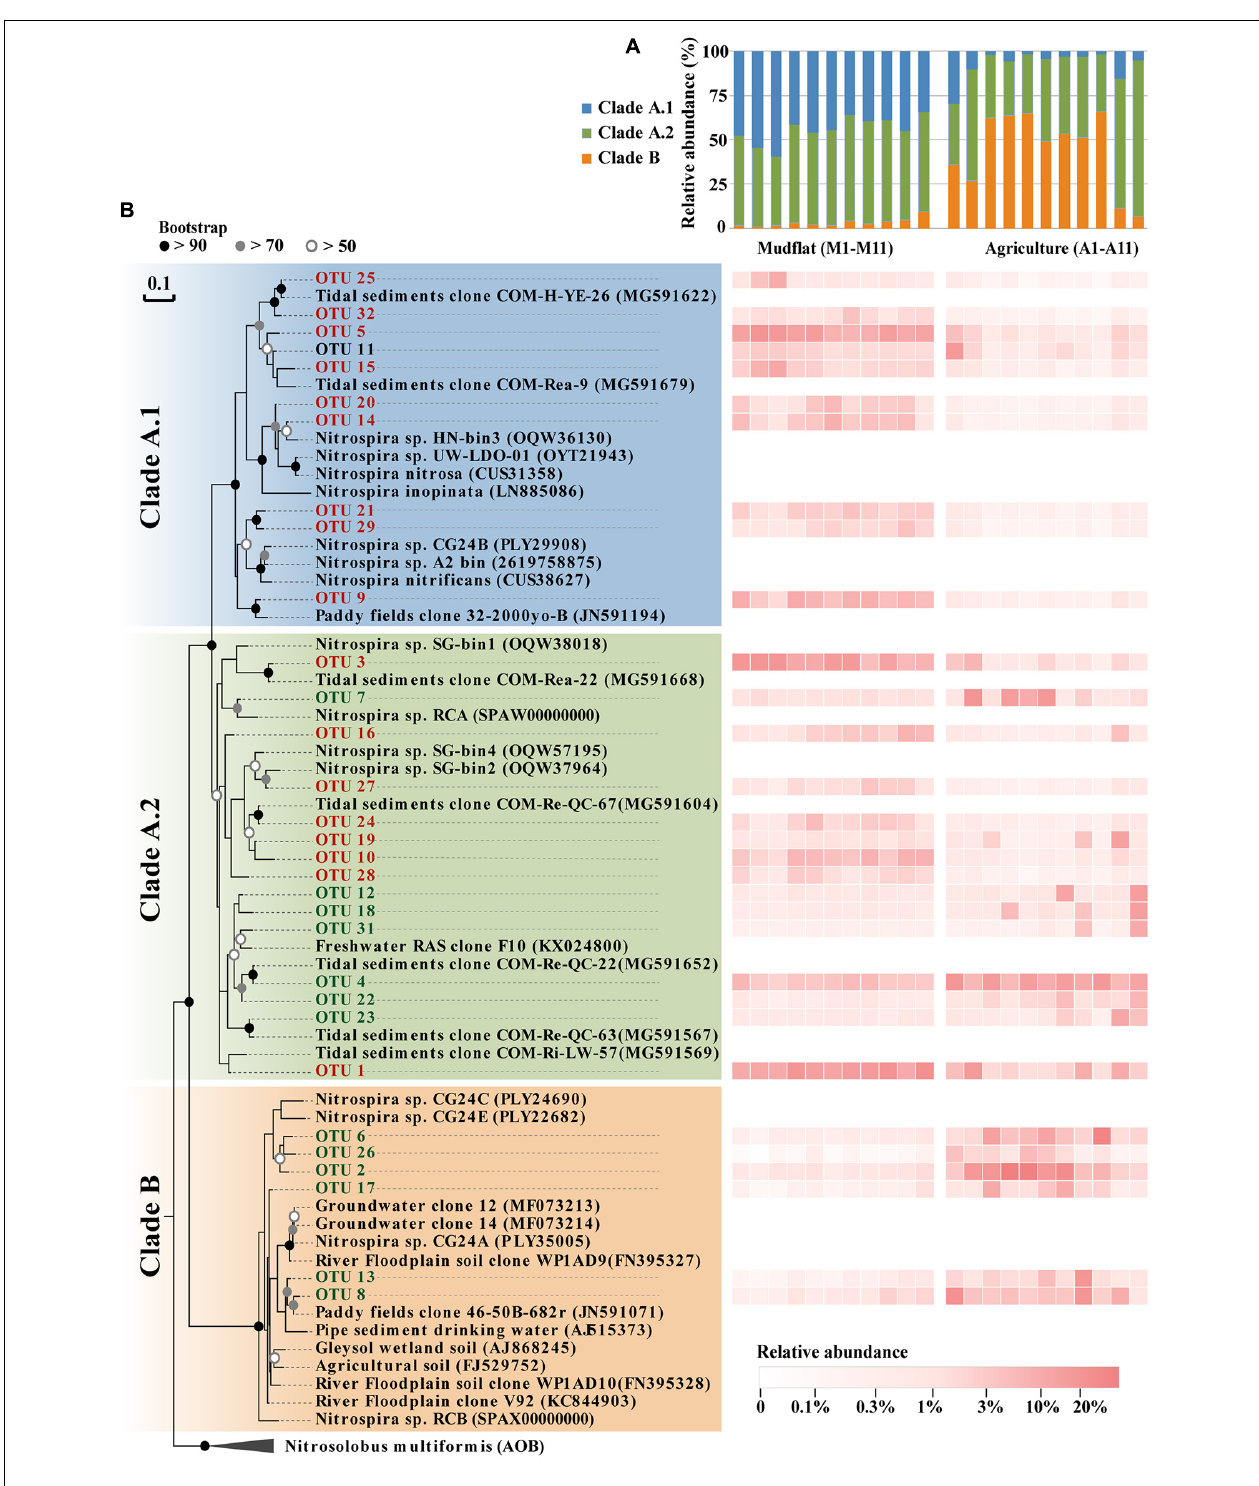
FIGURE 4 | Community composition of comammox Nitrospira in different sites of this study. (A) Relative proportions of the different clades of comammox Nitrospira in 22 different sites samples. (B) Phylogenetic tree and relative abundance of comammox Nitrospira amoA genes sequences. Dominate OTUs with a relative abundance > 1% were included in the phylogenetic analysis, accounting for 74% of the total comammox Nitrospira amoA gene sequences. The log value of relative abundance (%) of individual taxa in each site was displayed as a heat map representation. The phylogenetic position of each representative OTU was shown in the phylogenetic tree on the left-hand side. OTUs labeled in red represent mudflat-preferred OTUs (MPOs), OTUs labeled in green represent agricultural soil-preferred OTUs (APOs).